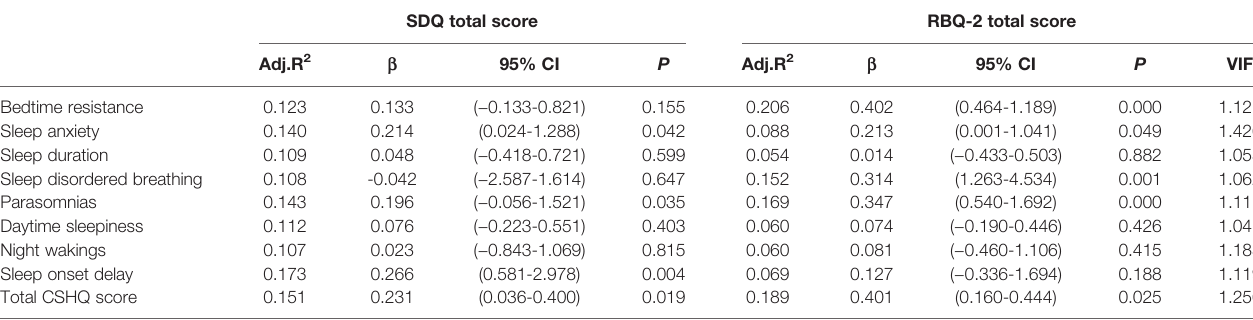
TABLE 6 | SDQ and RBQ-2 total scores by each domain of the CSHQ: adjusted linear regression results.